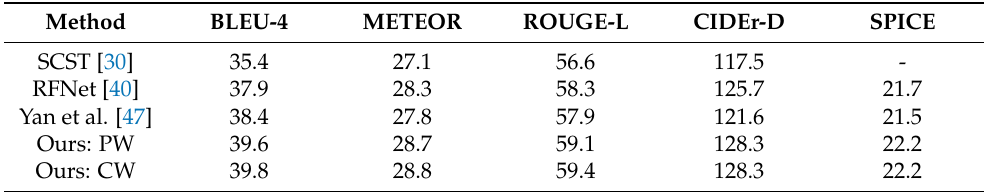
Table 3. The performance of our ensemble